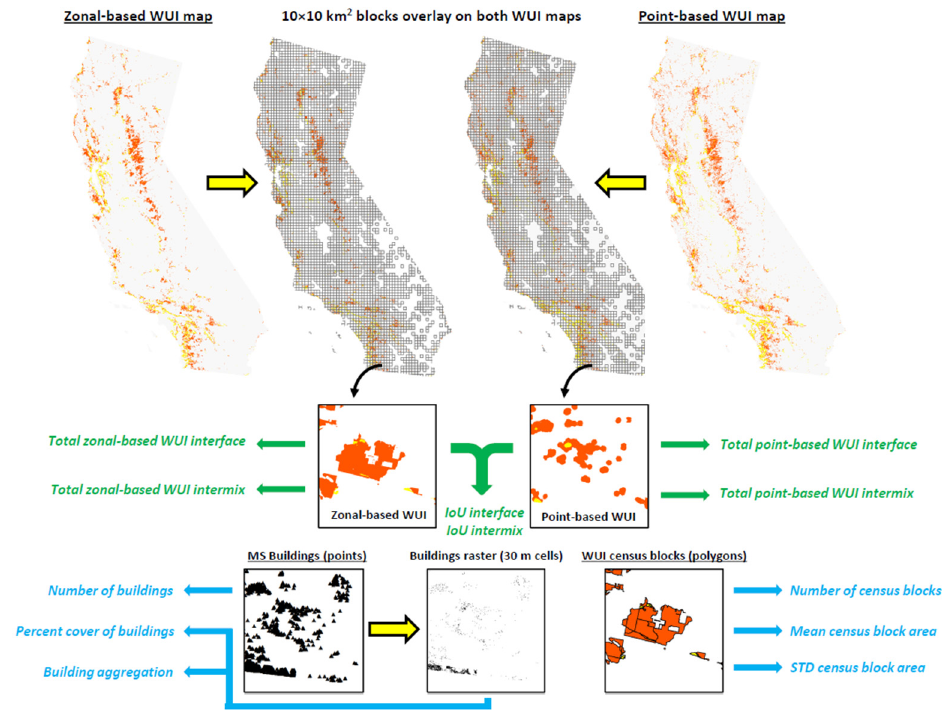
Figure 3. A flowchart depicting the generation of variables for statistical analyses. Existing data product names are underlined. Names in green italics are dependent variables in the analysis, and names in blue italics are predictor variables. Arrows connect between variables and their data source.